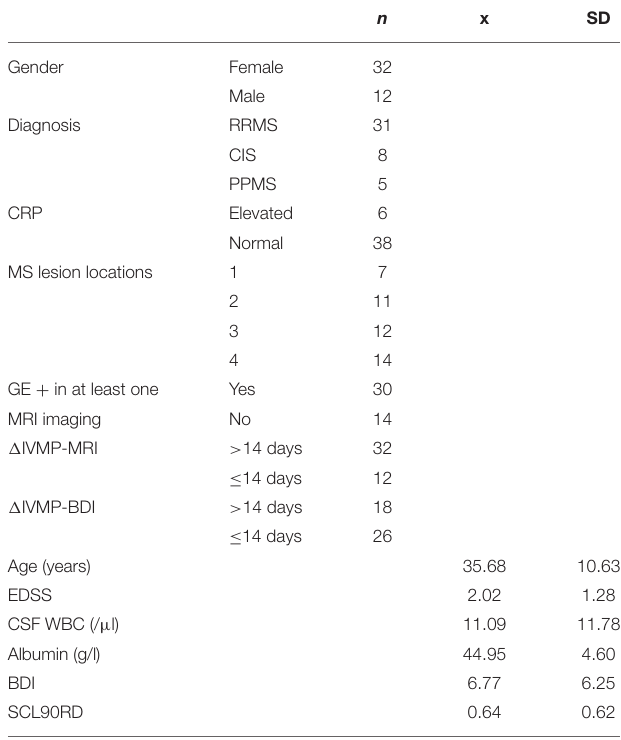
TABLE 1 | Descriptive statistics of the studied